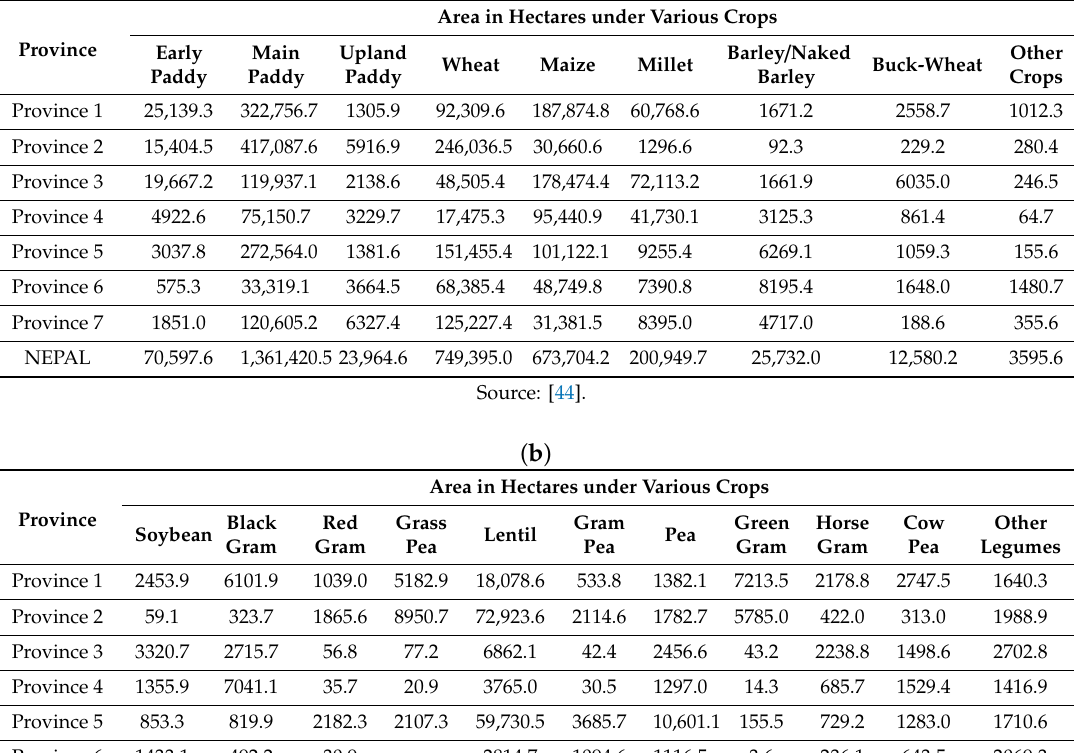
Table 3. Crops on arable land in various provinces. ( a